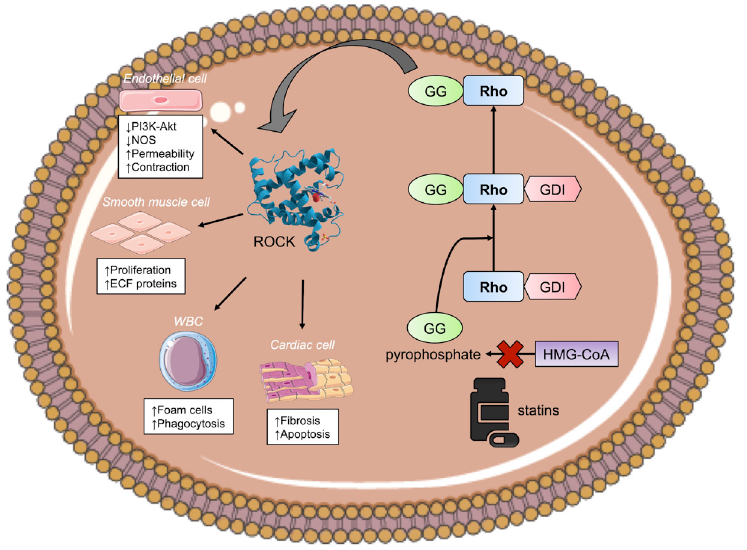
Figure 2. The mechanism of statins and regulation of the Rho GTPase cycle. Without statins, HMG-CoA is converted to mevalonate and subsequently geranylgeranyl (GG) pyrophosphate. The GG component is added to a complex of Rho protein and guanine nucleotide dissociation inhibitors (GDI) and therefore activates the Rho kinase (ROCK) pathway. ROCK mediates the downstream effects of Rho and has effect on endothelial cells, white blood cells, smooth muscle cells, and cardiac myocytes. The effect of statins inhibits the conversion of HMG-CoA to GG pyrophosphate which results in downregulation of ROCK and its associated effects on different target